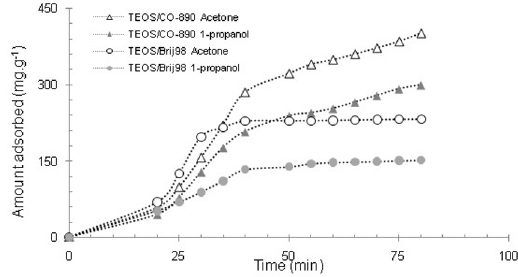
Figure 3. Nitrogen adsorption/desorption isotherms at 77 K of calcined samples in A: TEOS/DM-970, TEOS/CO-890 and TEOS/Triton-X100; in B: TEOS/Brij98; 13X/Brij98 Insert: pore size distribution (PSD) obtained by BJH method applied on desorption branch.